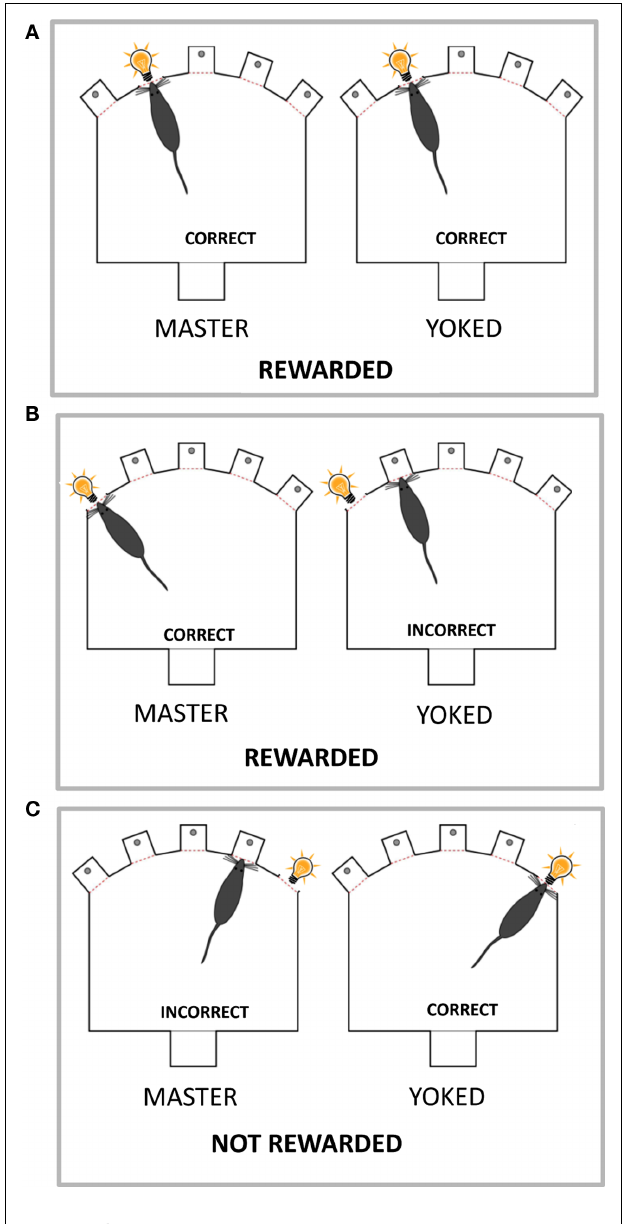
FIGURE 1 |The yoked animal receives stimuli and rewards not according to its behavior but according to the behavior of its master partner. Schematic representation of the box used to run the 5-CSRT task, with five holes set in a curved wall and a visual stimulus (light bulb; presented at random in one of the five holes for 0.5s). One the opposite wall is set the food magazine where the earned food pellets are delivered. The master and yoked rats have three possible outcomes. (A) Both master and yoked rats respond in the hole with stimulus on (correct response), and both are rewarded by food. (B) Master rat responds in the hole with stimulus (correct response) while yoked rat responds in a non-stimulus hole (incorrect response). As master rat gained a food pellet for its correct response, the yoked rat is also rewarded by food. (C) Master rat makes nose poke in a non-stimulus hole (incorrect response) whereas yoked rat makes a nose poke in the stimulus hole (correct response). As master rat made an incorrect response which is not rewarded the yoked rat is not rewarded